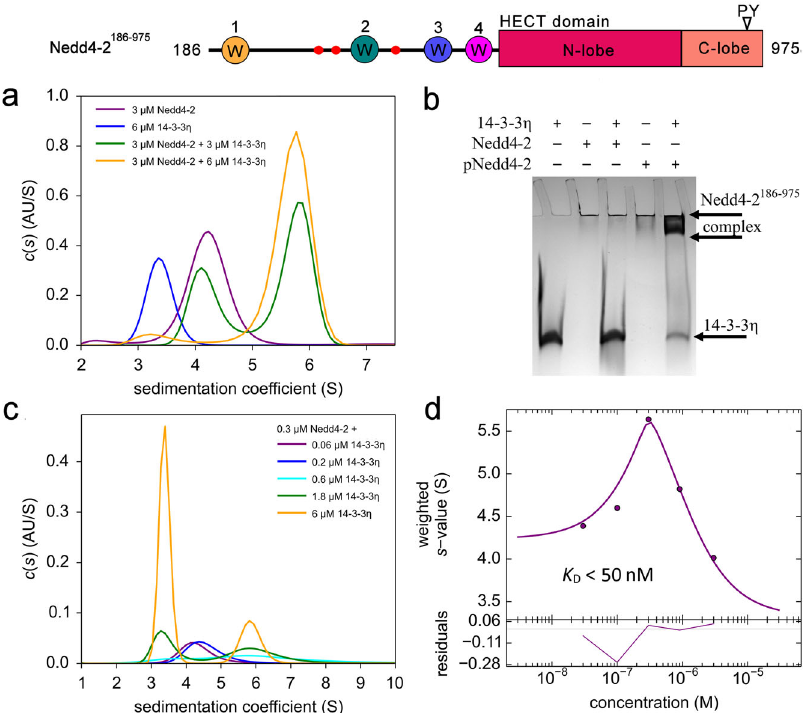
Fig. 2 Characterization of the interaction between Nedd4-2 186 – 975 and 14-3-3 in solution. a Continuous sedimentation coef fi cient distributions ( c(s) ) of 3 μ M pNedd4-2 186 – 975 alone (purple), 6 μ M 14-3-3 η alone (blue), and pNedd4-2 186 – 975 :14-3-3 η complex mixed at 1:1 (green) and 1:2 (yellow) molar ratios. b 12% TBE-PAGE showing the phosphorylation-dependent formation of a complex between pNedd4-2 186 – 975 and 14-3-3 η after loading 240 pmol of 14-3- 3 η and 120 pmol of Nedd4-2 186 – 975 or pNedd4-2 186 – 975 on the native gel, respectively. c Sedimentation coef fi cient distributions ( c(s) ) of mixtures of 300 nM pNedd4-2 186 – 975 with 0.06 − 6 μ M 14-3-3 η . d Isotherm of weight-averaged sedimentation coef fi cients ( s w ) derived from SV-AUC analysis of mixtures of 300 nM pNedd4-2 186 – 975 with 0.06 − 6 μ M 14-3-3 η . Based on our estimates, the K D value was lower than 50 nM, as further con fi rmed by global